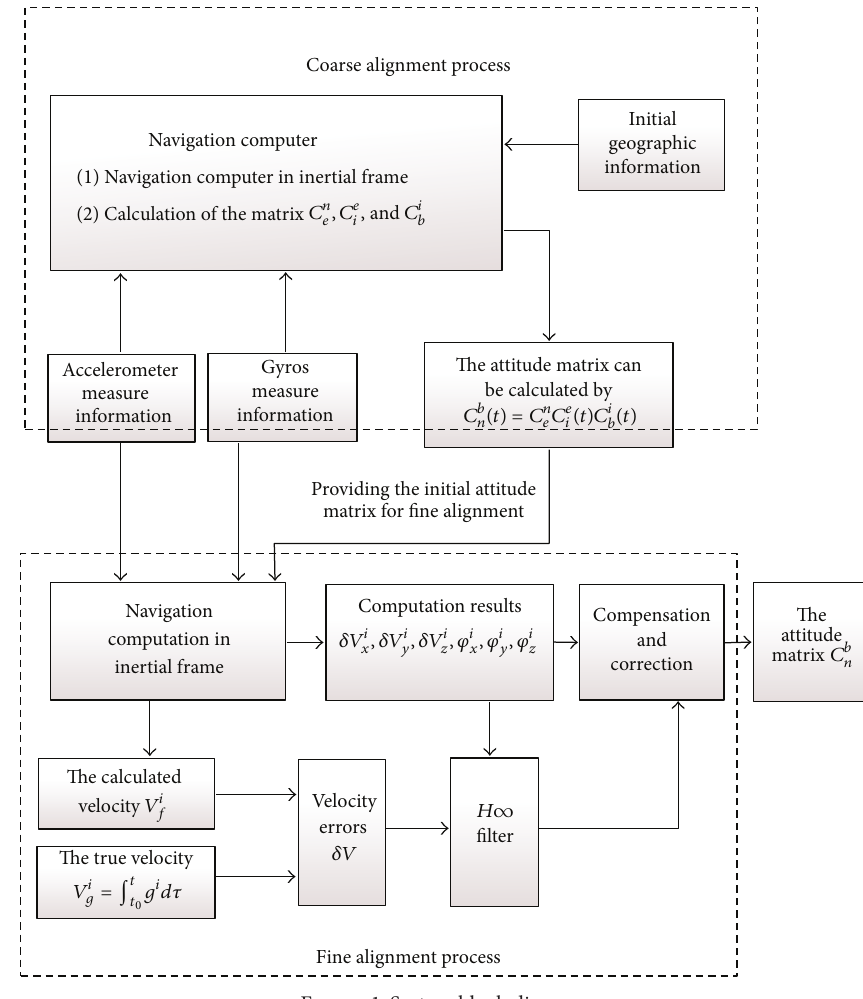
Figure 1: System block